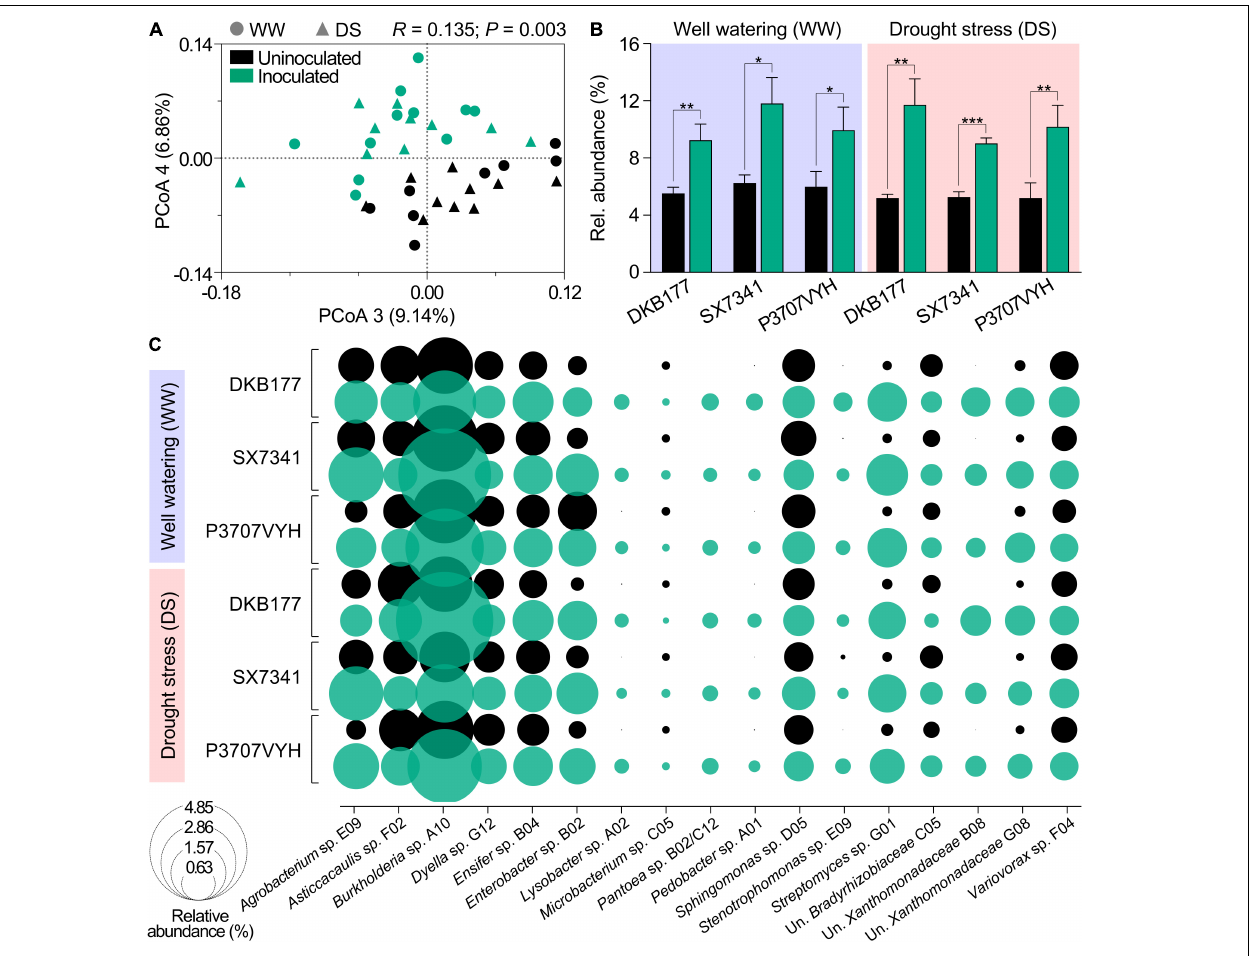
FIGURE 6 | Members of SynCom robustly colonize different maize hybrids. (A) PCoA of the Bray–Curtis dissimilarity matrix of inoculated and uninoculated plants. (B) Relative abundance of OTUs present in SynCom in WW- and DS-treated inoculated and uninoculated DKB177, SX7341, and P3707VYH hybrids. (C) Relative abundance of community-based isolates in SynCom in WW- and DS-treated inoculated and uninoculated maize hybrids. OTUs of community-based isolates identified as robust colonizers are individually highlighted in Supplementary Table 3 . Values expressed as the mean ± SD. PCoA, principal coordinates analysis; SD, standard deviation; Un., unknown. * P ≤ 0.05, ** P ≤ 0.01, and *** P ≤